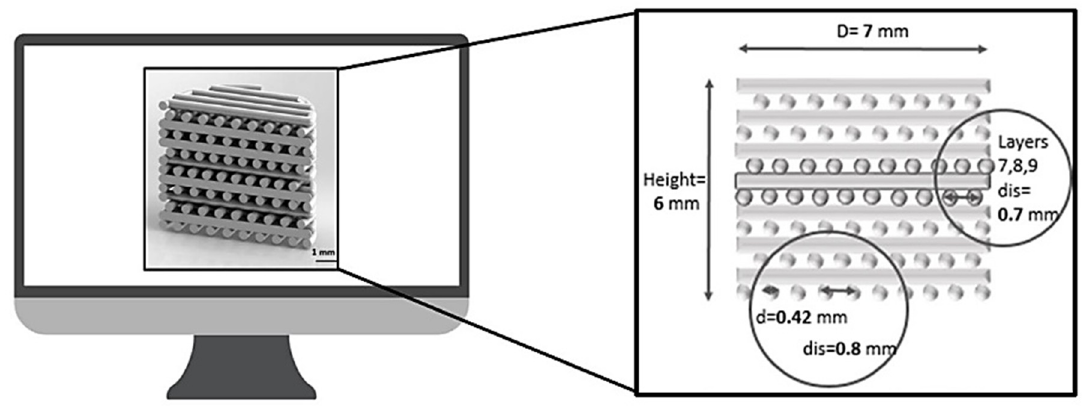
Figure 1. Multi-layer scaffold design (D = scaffold diameter; d = strand diameter; dis = strand distance).